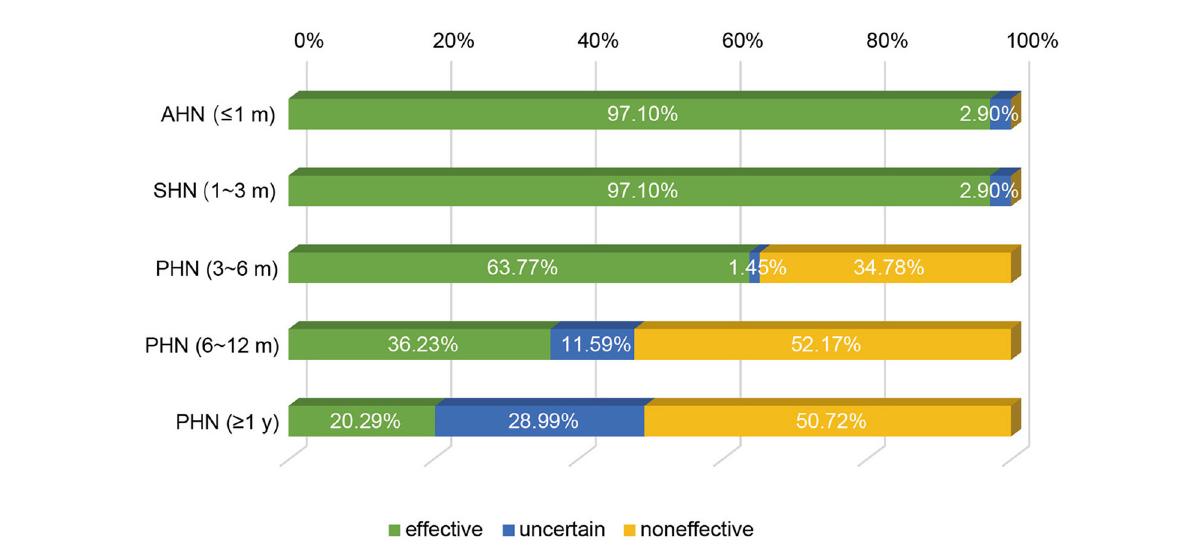
FIGURE2 Efficacy of st-SCS on HN treatment. 67/69 (97.10%) experts agreed that HN patients achieved good curative effect within 3 months (patient satisfaction rate ≥ 50%). Early PHN patients (3–6 months) had the same curative effect (44/69, 63.77%). More than half of the experts agreed that st-SCS is ineffective in PHN patients with more than 6 months of history.